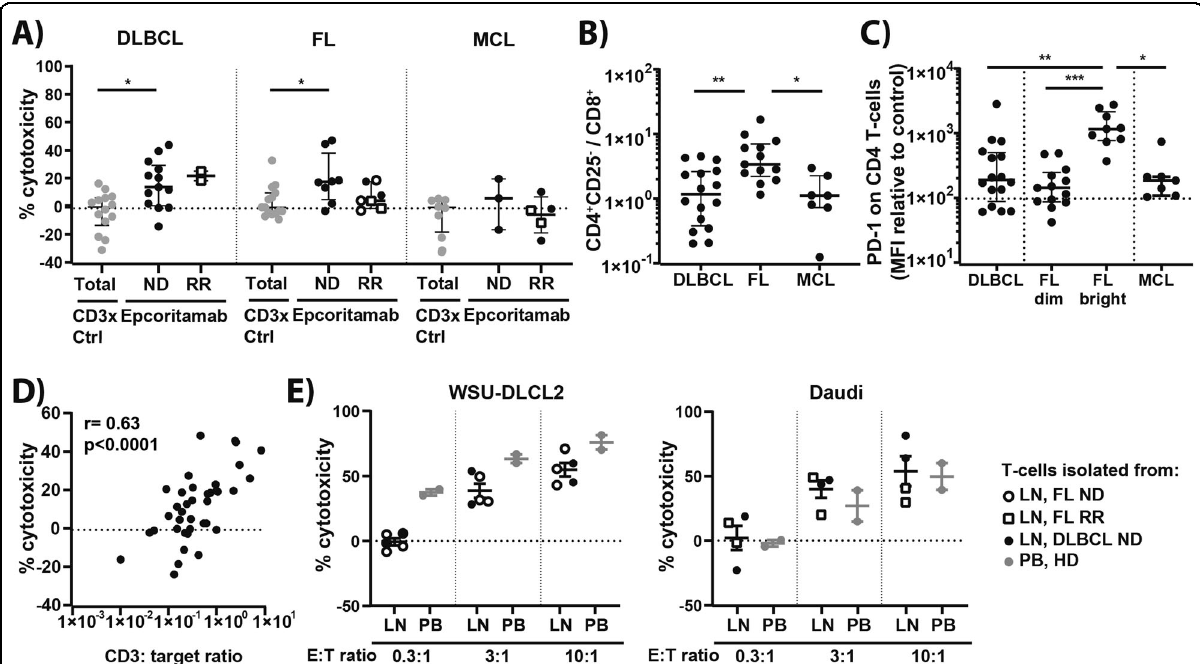
Fig. 4 The intrinsic capacity of T-cells from B-NHL LN samples to induce cytotoxicity is comparable to that of healthy donor T-cells. A Percentages cytotoxicity mediated by epcoritamab and CD3xCtrl (30 ng/mL) without addition of PBMCs in ND and RR DLBCL ( n = 15), FL ( n = 15), and MCL ( n = 8) samples (median ± interquartile range), including patients who relapsed from or were refractory to CD20 therapy ( and , respectively). Statistical analysis was performed with Kruskal – Wallis and Dunn ’ s multiple comparisons test to compare epcoritamab with CD3xCtrl (* p < 0.05) and to compare epcoritamab-dependent cytotoxicity (subtracted with CD3xCTRL values) between subtypes (ns). B Ratio of CD4 + T helper cells (CD4 + CD25 − ) to CD8 + T-cells in DLBCL, FL, and MCL samples (Kruskal – Wallis with Dunn ’ s multiple comparisons test; * p < 0.05, ** p ≤ 0.01) (median± interquartile range). C PD-1 expression (MFI values normalized to expression on T-cells of internal healthy donor control) on CD4 + T-cells of DLBCL, FL, including PD-1 bright and dim populations, and MCL (Kruskal – Wallis with Dunn ’ s multiple comparisons test; * p < 0.05, ** p < 0.01, *** p < 0.001) (median ± interquartile range). D Spearman ’ s correlation between CD3:Target ratio and cytotoxicity mediated by epcoritamab (30 ng/mL) ( r = 0.63; **** p < 0.0001). E Lymph node T-cells of B-NHL patients isolated by magnetic-activated cell-sorting (MACS) showed similar percentages B-cell lymphoma cell line (WSU-DLCL2 and Daudi, left to right) cytotoxicity as T-cells isolated from healthy donor PB (mean ± SEM) (Mann – Whitney U - test;